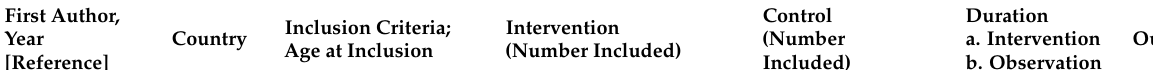
Table 3. Overview of references with